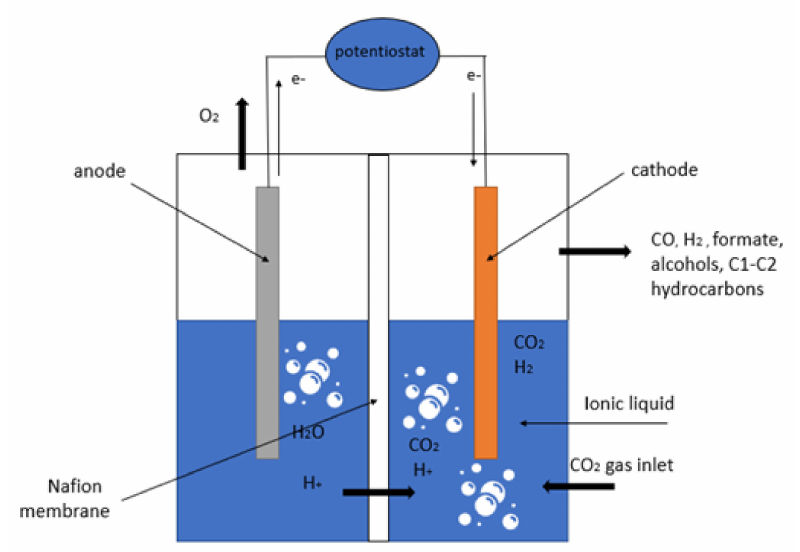
Figure 2. Illustration of an electrochemical H-cell for CO 2 reduction.